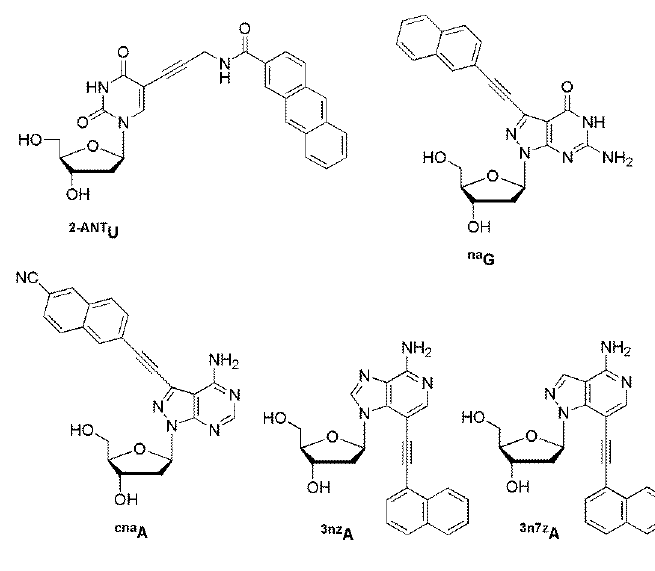
Figure 16. ESF probes.